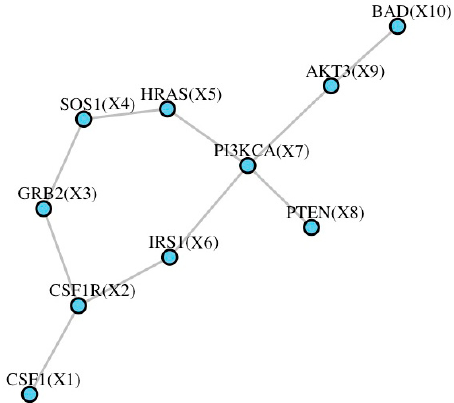
Figure 1. The simulated network for the PI3K-AKT signaling pathway from